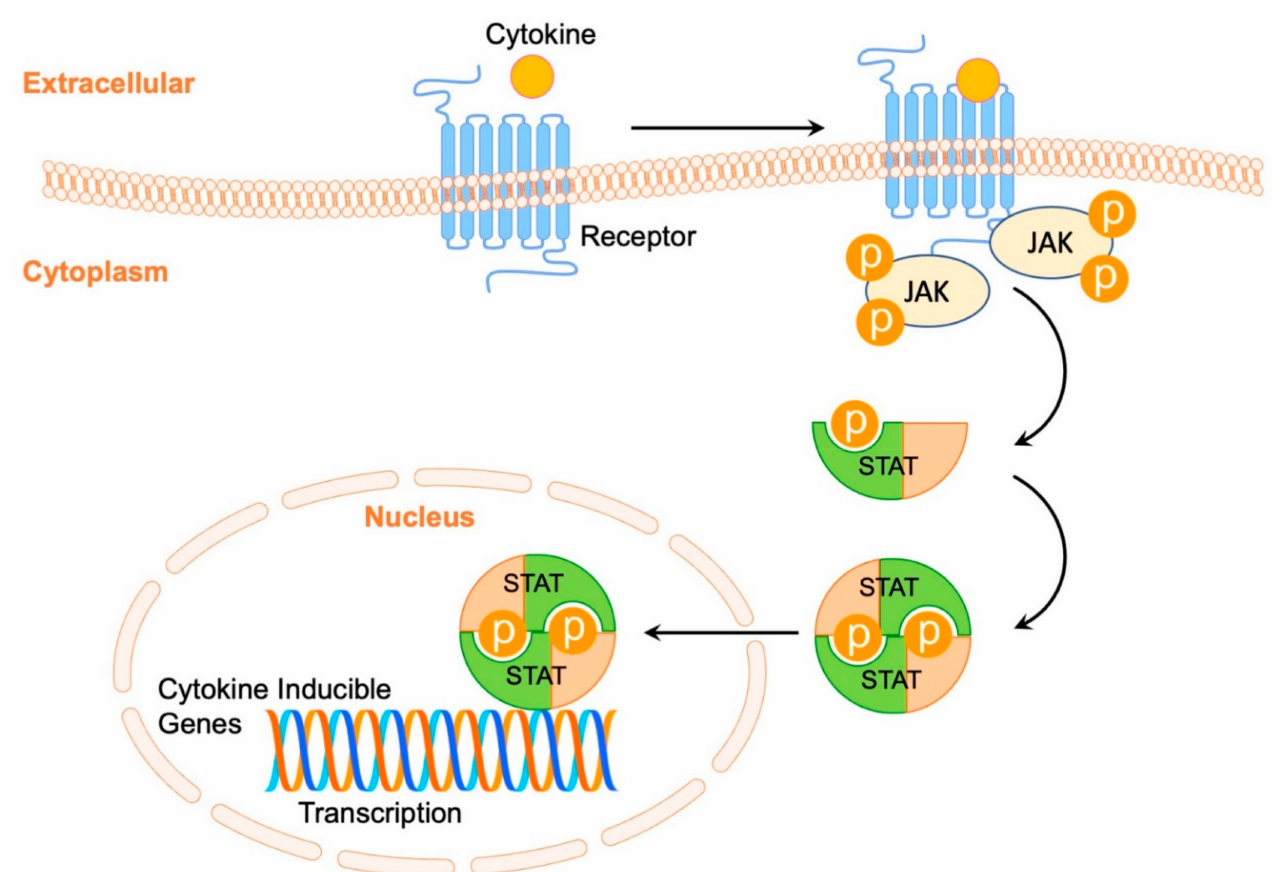
Figure 1. JAK-STAT pathway is a master regulator of immune function. Cytokines bind to their respective receptor, which cause the phosphorylation of JAK and activation of STAT proteins. Upon activation, STAT proteins dimerize, translocate into the nucleus, and upregulate transcription of proinflammatory cytokines and growth